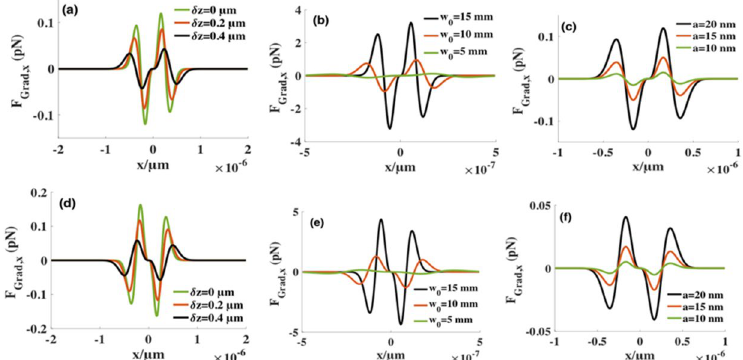
Figure 6. The changes of the transverse gradient forces for several values on high-index and low-index spheres, respectively. For ( a ) and ( d ), the beam waist w 0 = 5 mm and particle radius a = 20 nm . For ( b ) and ( e ), particle radius a = 20 nm and the distance δ z = 0 from the focus point . For ( c ) and ( f ), the distance δ z = 0 from the focus point and the beam waist w 0 = 5 mm . Other parameters are (cid:31) = 1.064 µ m , g = 1 , f = 5mm , and P = 4 w